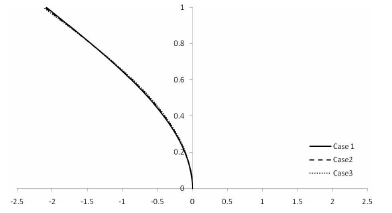
Figure 10. Modeshapes for the second mode – linear